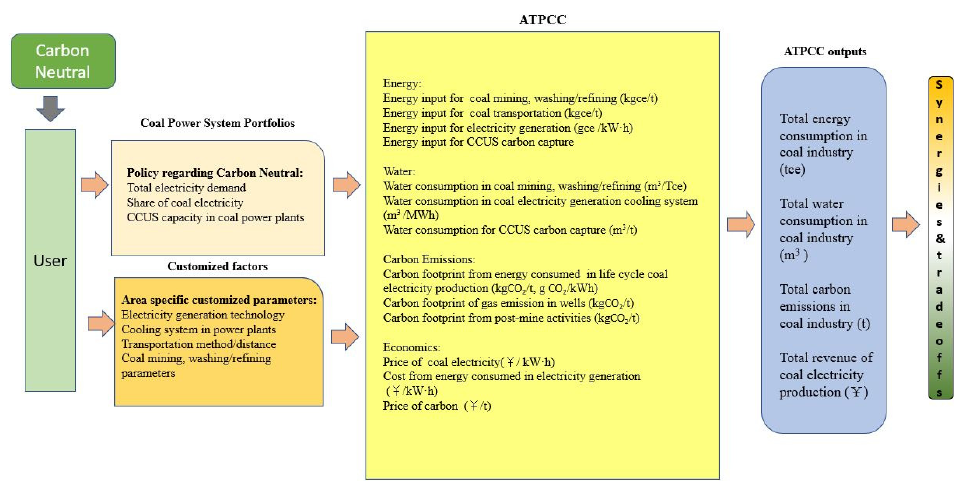
Figure 2. The Assessment Tool for Portfolios of Coal power production under Carbon neutral goals (ATPCC) structure.